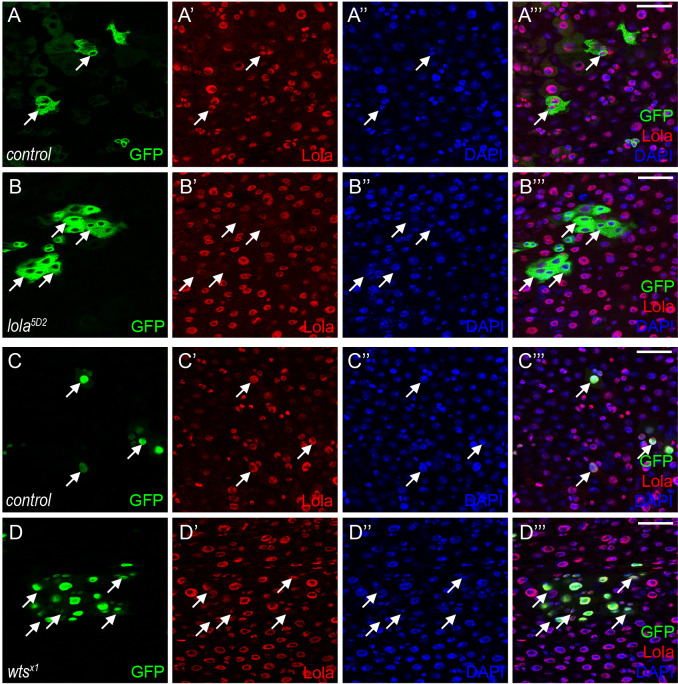
Wts affects Lola protein levels in vivo.(A-B’’’) Representative images of Drosophila adult midguts containing GFP positive MARCM clones of control (A-A’’’) and the hypomorphic allele lola5D2 (B-B’’’) immunostained with Lola (red) and DAPI (nuclei, blue). Merged images are shown in A’’’ and B’’’ (green, red, and blue). Note a decrease in Lola protein levels in lola5D2 clones (white arrows in B’). (C-D’’’) Representative images of Drosophila adult midguts containing GFP positive MARCM clones of control (A-A’’’) and wtsx1 (B-B’’’) immunostained with Lola (red) and DAPI (nuclei, blue). Merged images are shown in C’’’ and D’’’ (green, red, and blue). Note a decrease in Lola protein levels in wtsx1 clones (white arrows in D’). Scale bars: 30 μm. At least 10 midguts were dissected for each genotype. Confocal images were taken from the basal layer of the midgut where ISCs can be clearly visualized. Single layer image is shown.